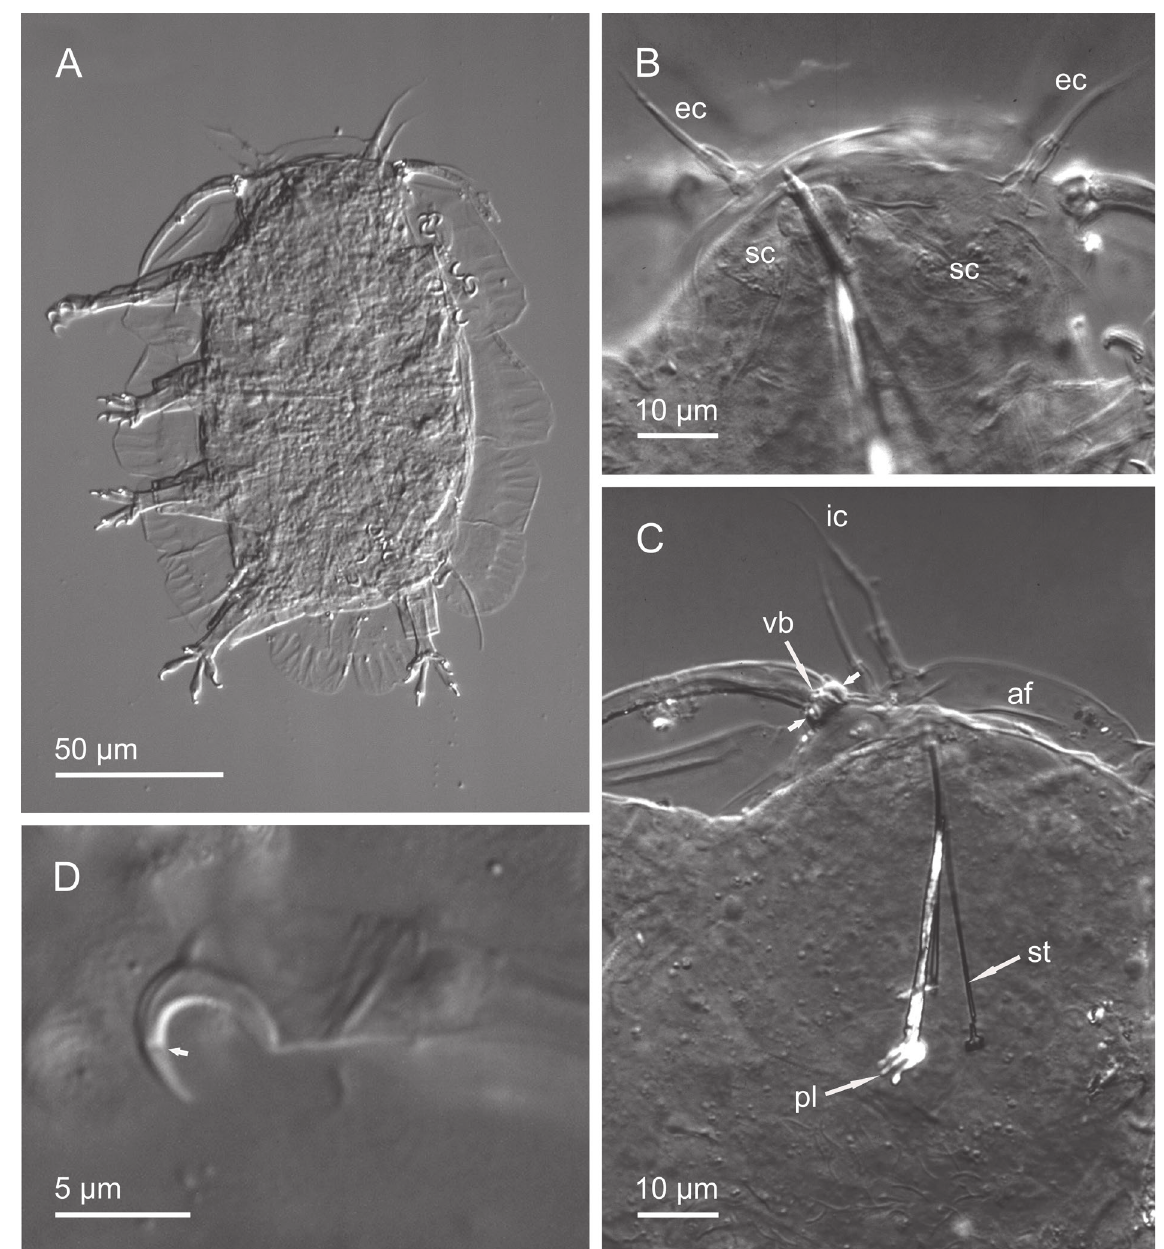
Fig. 7. DIC-micrographs of Higginsarctus signeae gen. et sp. nov., allotype, ♂ (NHMD-293900). A . Overview. B . Close up on the head, ventral view showing the external cirri, secondary clavae and the very refractive cupola of the mouth cone. Note the presence of bacteria underneath the secondary clavae. C . Close up on the bucco-pharyngeal apparatus and the insertion of the primary clava with large refractive structures inside the base (white solid arrows) and van der Land’s body. D . Close up on the external claw of leg I, with evident internal notch (white solid arrow). Abbreviations: see Material and